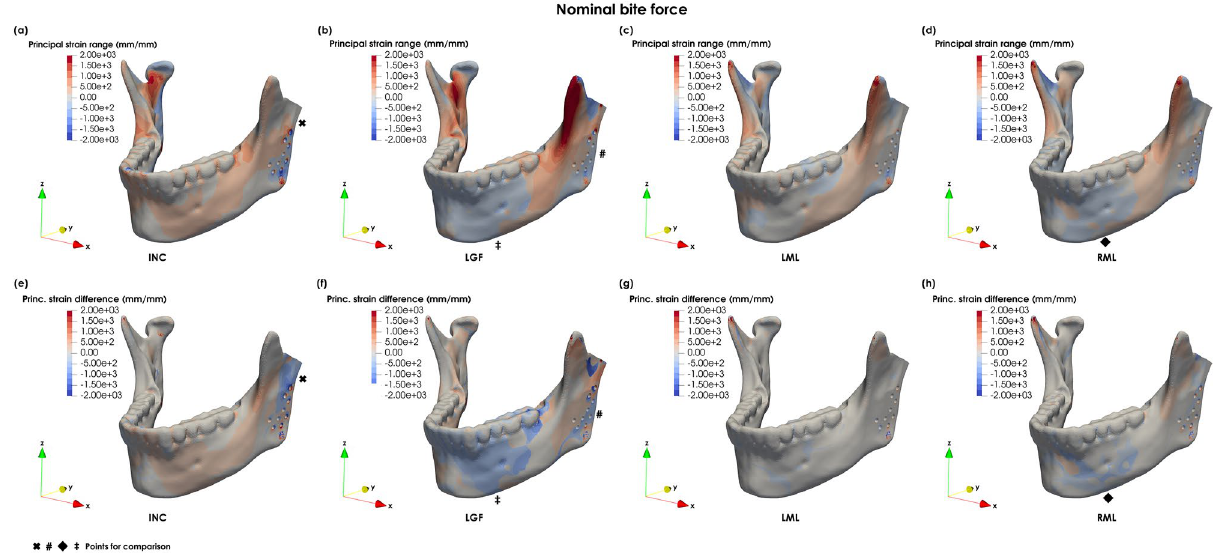
Figure 5. Principal strain distribution during ( a ) incisor biting (INC), ( b ) left group biting (LGF), ( c ) left molar biting (LML) and ( d ) right molar biting (RML) for the implanted mandible and principal strain differences ε between intact and implanted mandible under ( e ) incisor biting (INC), ( f ) left group biting (LGF), ( g ) left molar biting (LML), and ( h ) right molar biting (RML) (with not lateral pterygoid